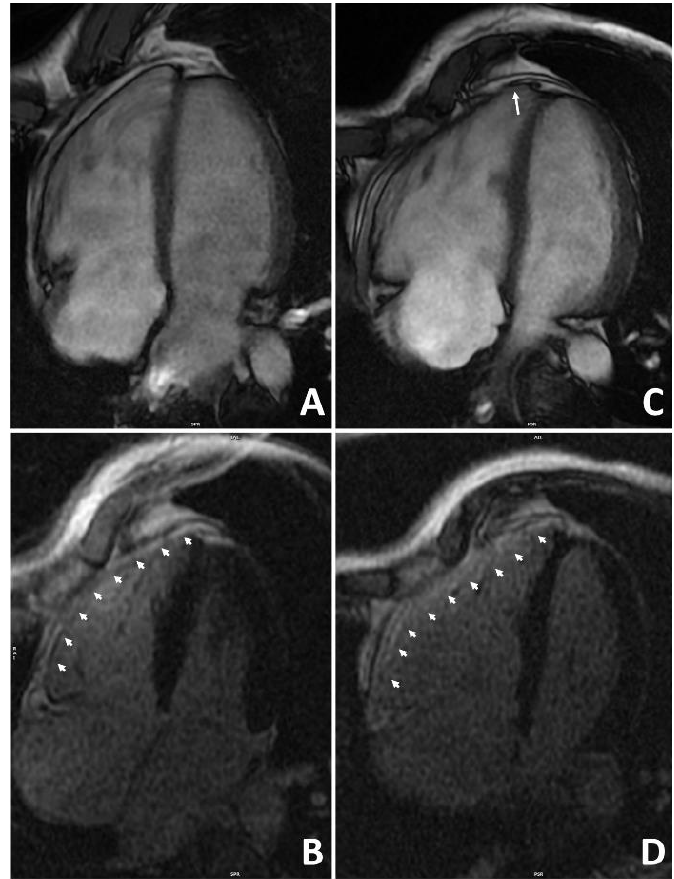
Figure 4. Representative example of the role of endurance exercise in worsening the arrhythmo- genic cardiomyopathy phenotype. A 38-year-old runner received a diagnosis of arrhythmogenic cardiomyopathy after investigating ventricular arrhythmias and ECG abnormalities at preparticipa- tion screening. Genetic testing was positive for plakophilin-2 gene mutation. At the time of diagnosis, cardiac magnetic resonance 4-chamber view on cine sequences found dilatation of the right ventricle with mild dysfunction ( A ) and diffuse right ventricular late-enhancement on post-contrast sequences ( B ). Although he was considered not eligible for competitive sports activity according to Italian law, he continued to practice high-intensity endurance training. After 4 years, repeat cardiac magnetic resonance showed a more enlarged right ventricle, an apical aneurysm (arrow), and a moderate right ventricular dysfunction ( C ). Post-contrast sequences confirmed diffuse right ventricular late enhancement ( D ). Reproduced with permission from Zorzi et al. [92].